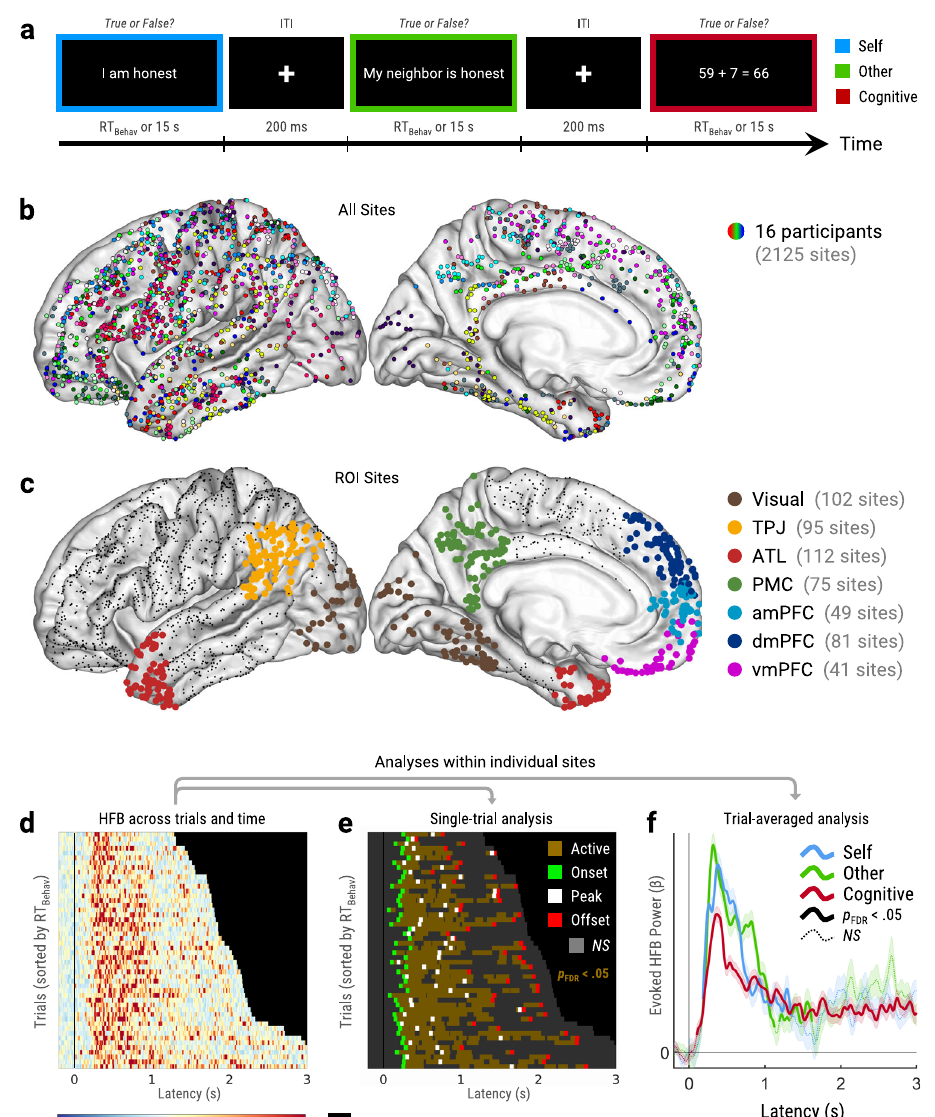
Fig. 1 Data and design. Brain maps in main fi gures plot all sites in left-hemisphere Montreal Neurological Institute space for display purposes. a Behavioral task (see Supplementary Table 4). b Map of electrode sites colored by participant. c Region-of-interest sites (ROI; colored circles) and non-ROI sites (black dots). ROIs were de fi ned using each participant ’ s native cortical surface. d – f Within-site analytic pipeline using a mid-cingulate exemplar site. d High- frequency broadband power (HFB; 70 – 180 Hz) across timepoints and trials. Black areas indicate discarded timepoints (post-trial). e Single-trial analysis compared evoked HFB power versus pre-stimulus baseline (Welch ’ s tests) to provide fi ve key HFB metrics. Duration: total timepoints with signi fi cant activations (brown areas; p FDR < 0.05, corrected across timepoints, trials, and sites). Onset Latency: earliest timepoint with signi fi cant activation (green squares). Peak Latency and Peak Power: timepoint and magnitude, respectively, of the strongest activation (white squares). Offset Latency: latest timepoint with signi fi cant activation (red squares). Gray areas indicate nonsigni fi cant ( NS ) activations. f Trial-averaged analysis identi fi ed sites that were active, deactive, or nonresponsive for each task condition. Sites were considered ‘ active ’ or ‘ deactive ’ if evoked HFB power was signi fi cantly higher or lower, respectively, than pre-stimulus baseline ( p FDR < 0.05, corrected across timepoints and sites). Colored lines show mean timecourses of evoked HFB power ( β ) estimated by linear mixed-effects modeling (nested within Trial). Thick solid lines indicate signi fi cant responses. Thin dashed lines indicate nonsigni fi cant responses. Shaded areas indicate standard error of β . Abbreviations : s = seconds, ms = milliseconds, ITI = inter-trial interval, RT Behav = behavioral response time, Visual = visual cortex, ATL = anterior temporal lobe, TPJ = temporoparietal junction, PMC = posteromedial cortex, amPFC = anteromedial prefrontal cortex, dmPFC = dorsomedial prefrontal cortex, vmPFC = ventromedial prefrontal cortex, p FDR = p -value adjusted for false discovery